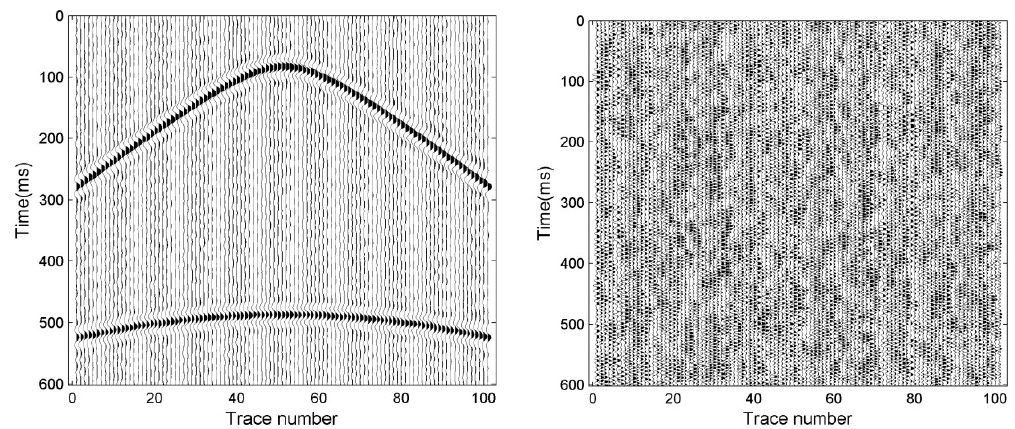
Figure 8. Random noise attenuation results ( left ) and the noise ( right ) by ICEEMD.